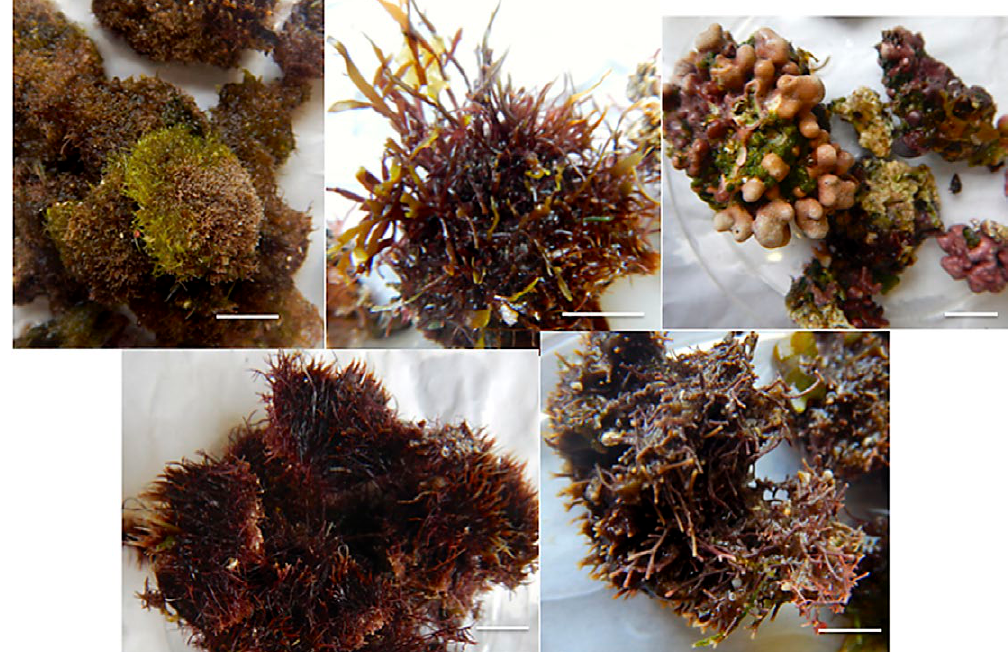
Fig. 4. – Trindade Island turfs. These associated macroalgae form broad tangled mats, often growing on other calcareous algae (branched or crustose), along the intertidal and shallow subtidal zones. Scale=1